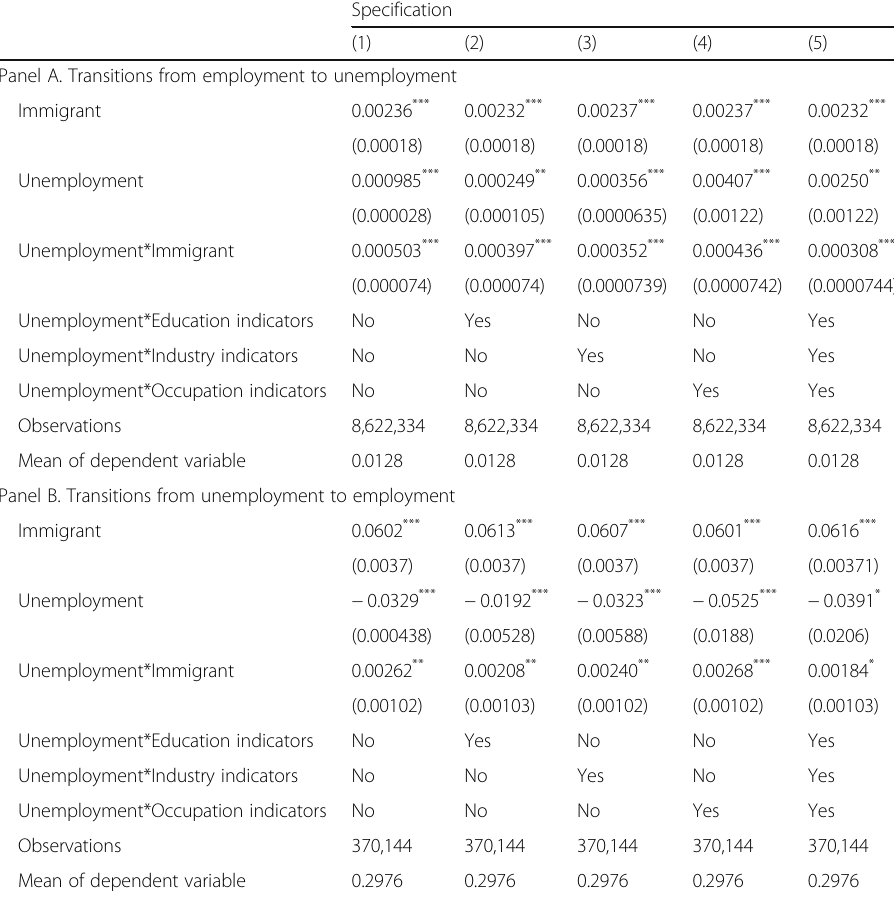
Table 10 Tests for the influence of education, occupation, and industry based on two-way transitions: matched CPS data, 1996 –